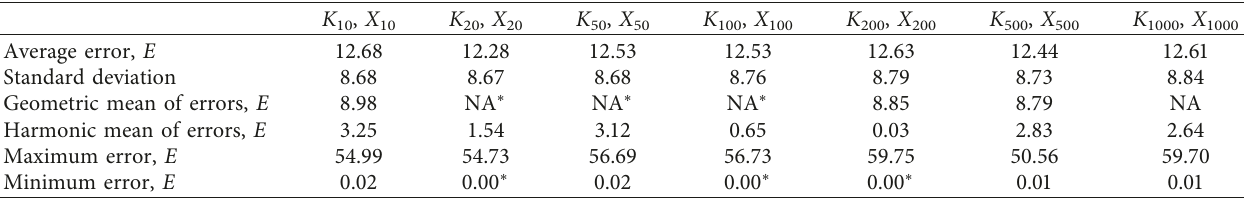
Table 1: Results of Monte Carlo simulation: error of estimation E for different ranges of molar concentration of reactants and reaction